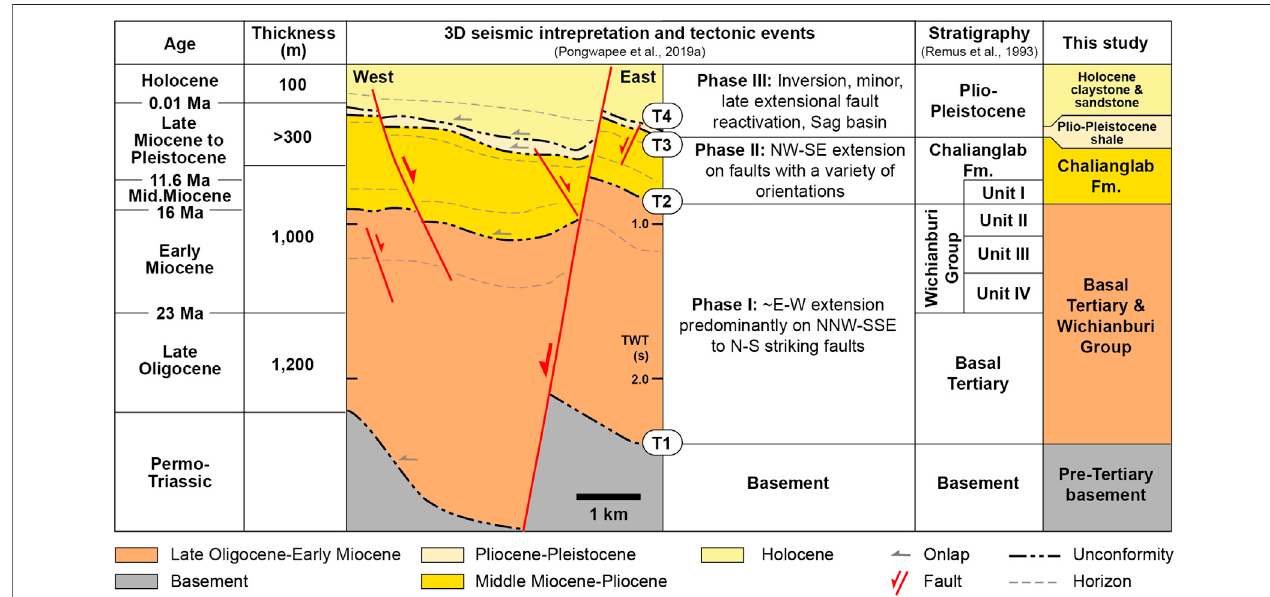
FIGURE3| Comparisonofseismicstratigraphy andtectoniceventswithkeyunconformities(T1 – T4).Locationof3Dseismicinterpretationislocatedin Figure1B .